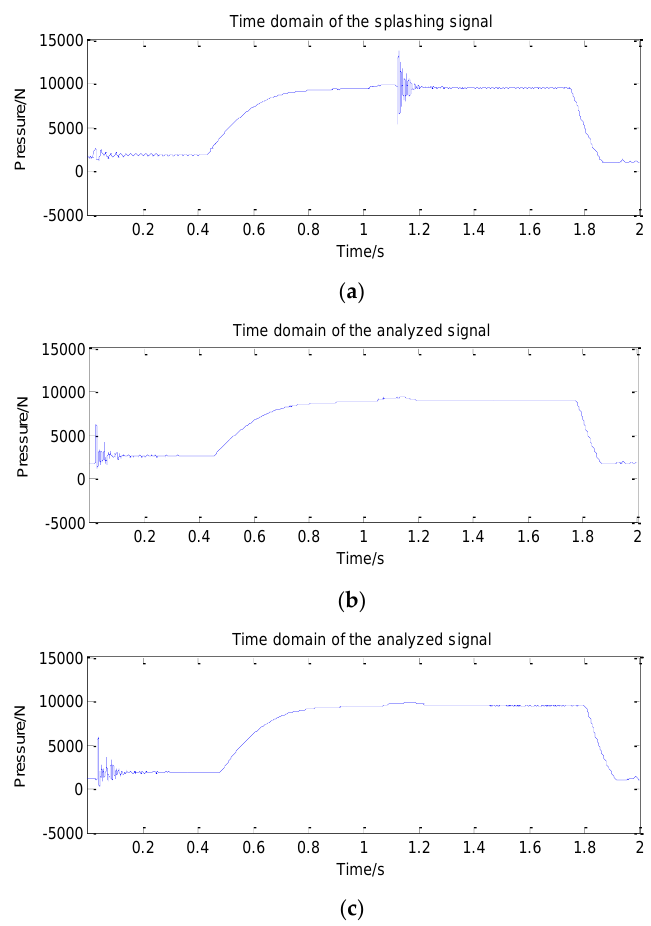
Figure 6. The time domain of the electrode force signal: ( a ) the expulsion signal; ( b ) other signal 1; ( c ) other signal 2.